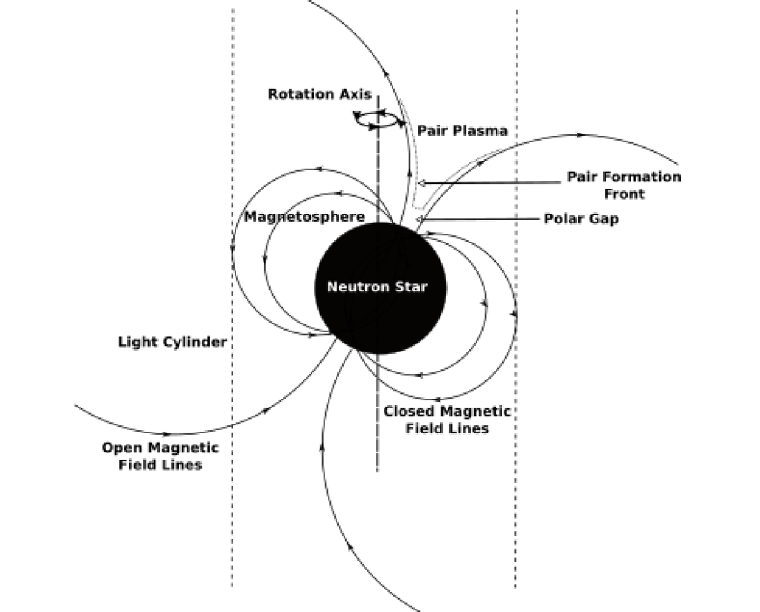
Figure 2 . A schematic representation of the various relevant NS regions. Over the polar gap regions, the charge density is low and very high electric (cid:12)elds are generically present. NS are compact, rotating objects with large magnetic (cid:12)elds in general. Radio